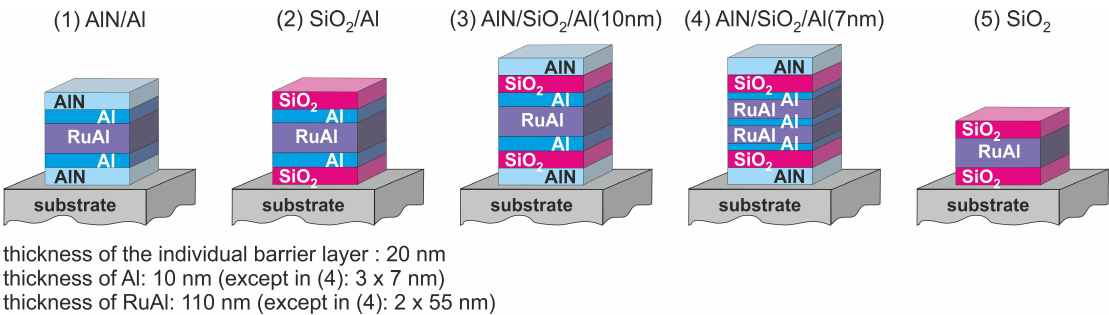
Figure 1. Architecture and notation of the different samples. As substrate materials thermally oxidized Si (SiO 2 /Si), CTGS and LGS are